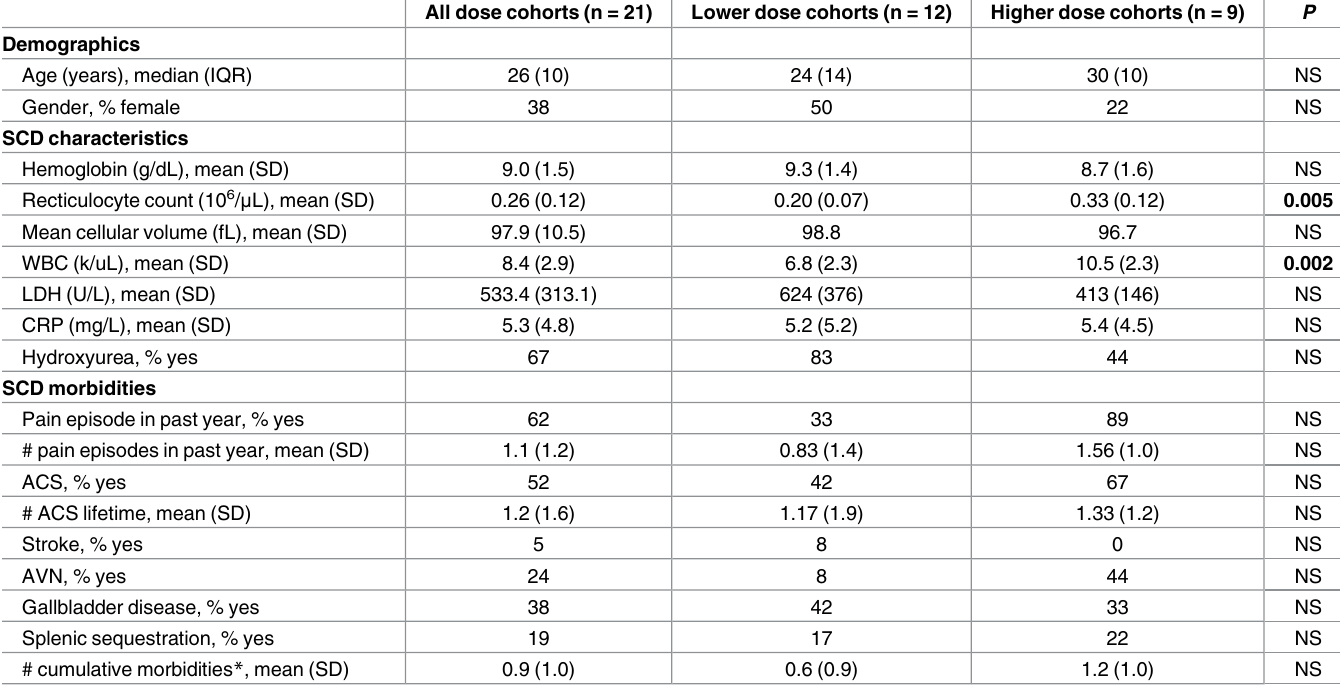
Table 1. Demographics, sickle cell disease characteristics and